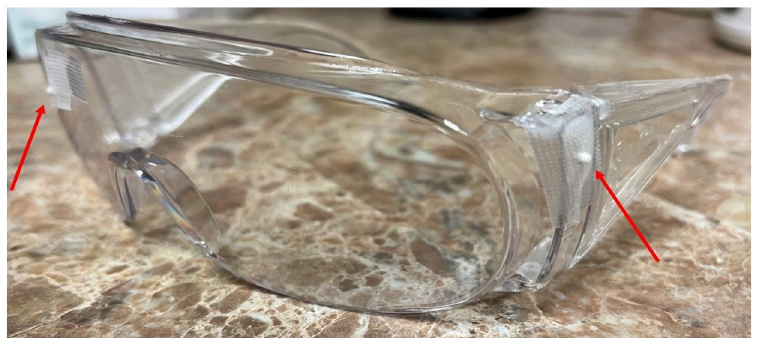
Fig 2. Goggles apparatus. Radiolucent plastic lab goggles worn by the patient with point sources attached to it. Two sources were placed on two sides of the goggles, and one placed on the front near the forehead of the patient. In the figure, two point sources can be seen to be indicated by two red